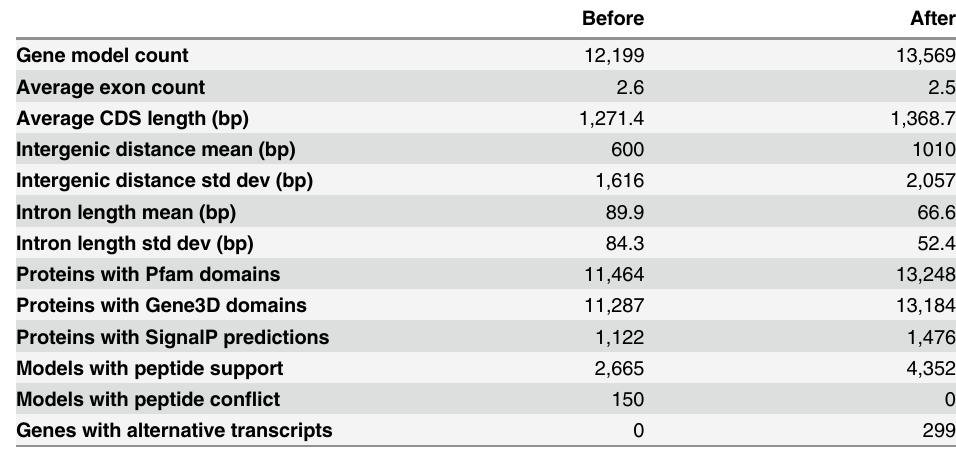
Table 3. Summary of the characteristics of annotated P . nodorum SN15 genes and their protein prod- ucts before and after manual re-annotation. Manually-annotated genes are longer, have more annotated transcripts, are more likely to accord with proteomic data, and are more likely to have conserved protein domains.